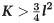
The retailer's profit and utility with α in K>34l2.